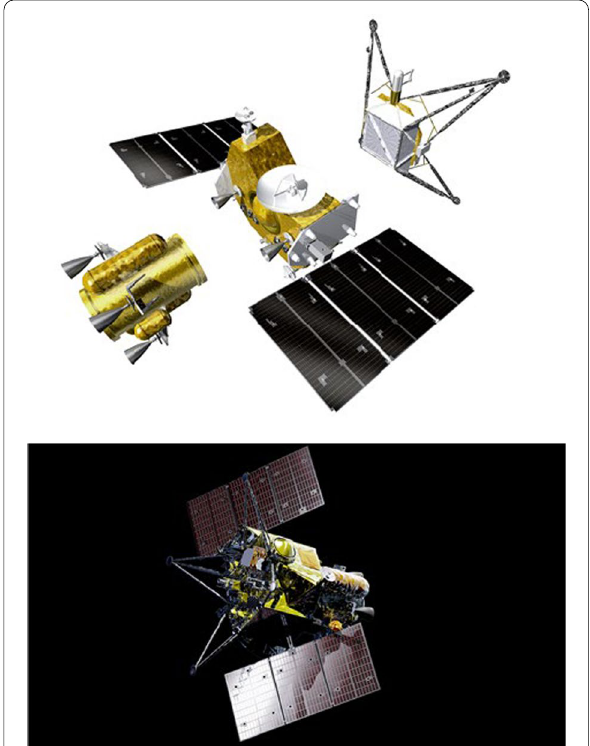
Fig. 1 The current design of spacecraft system configuration. (Top) From left to right, propulsion, exploration, and return modules. (Bottom) On‑orbit configuration. The size of a solar panel is 2.4 m 4.4 m. (C) ×